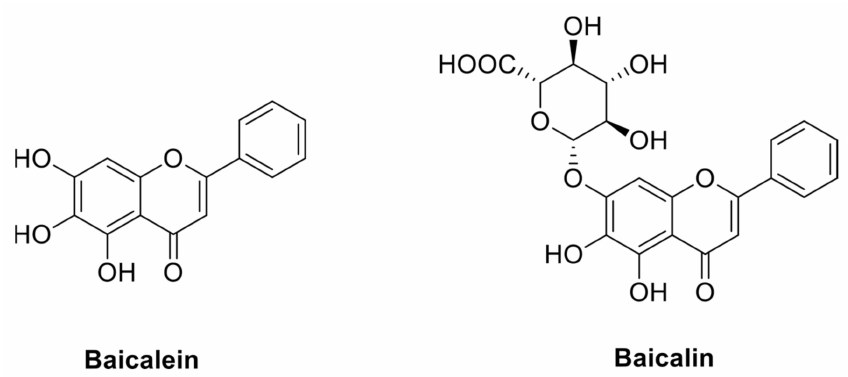
Figure 1. Chemical structure of baicalein and